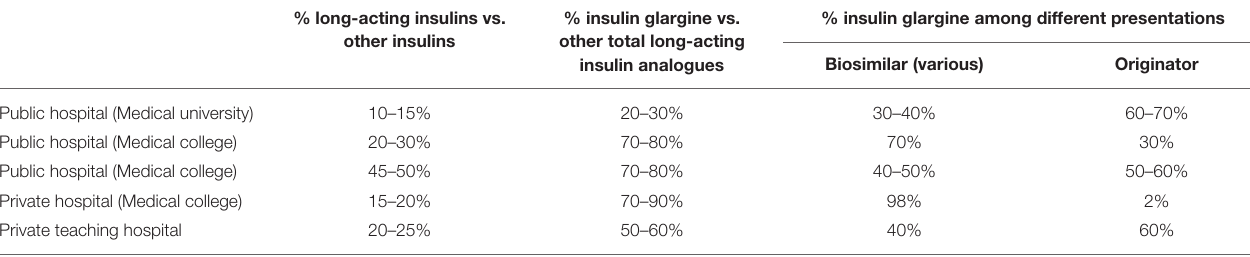
TABLE 3 | Range of insulin prescribing patterns among the surveyed hospitals in Bangladesh [adapted from (35)]. % long-acting insulins vs. other insulins